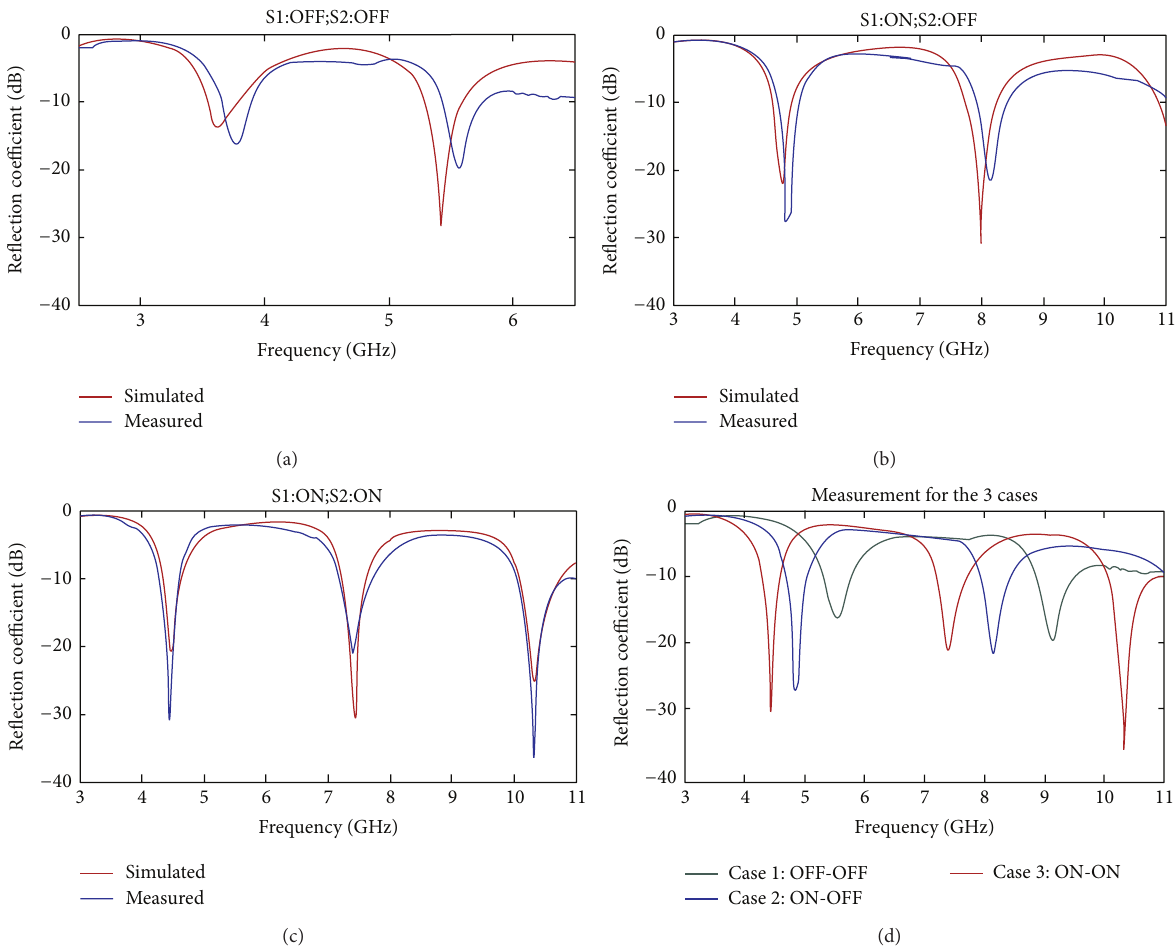
Figure 8: Geometry and photo of the dual-port ultrawideband-narrowband antennas in [65].